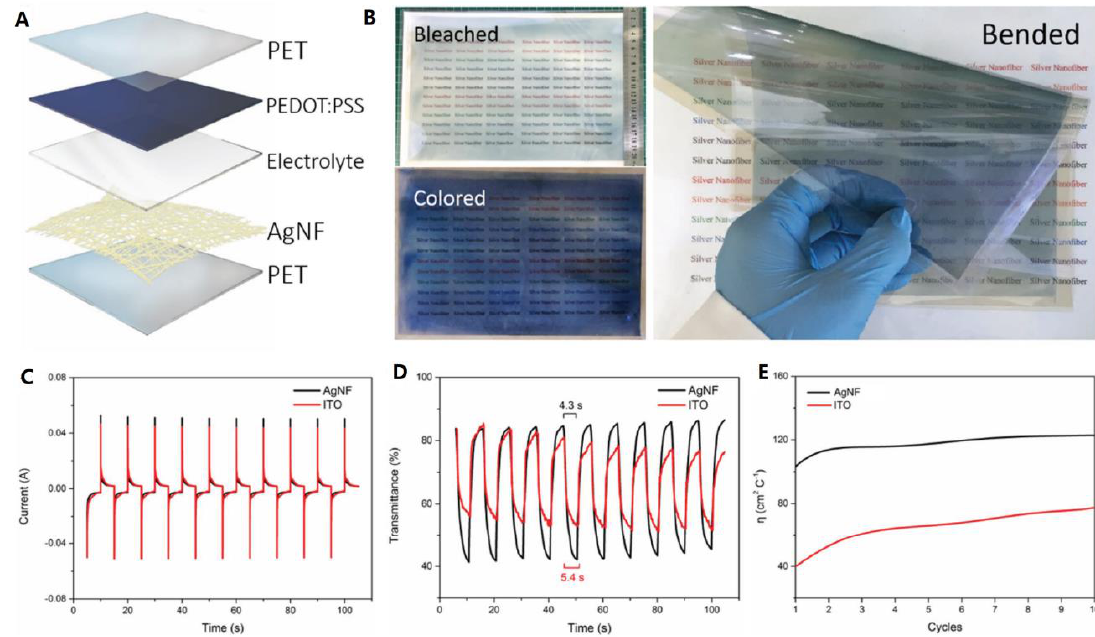
Figure 17. ( A ) structural schematic of AgNW-based electrochromic window (ECW), ( B ) flexible A4-sized ECW, ( C ) current response, ( D ) transmittance response, and ( E ) coloration efficiency during the first 10 switching cycles [87].